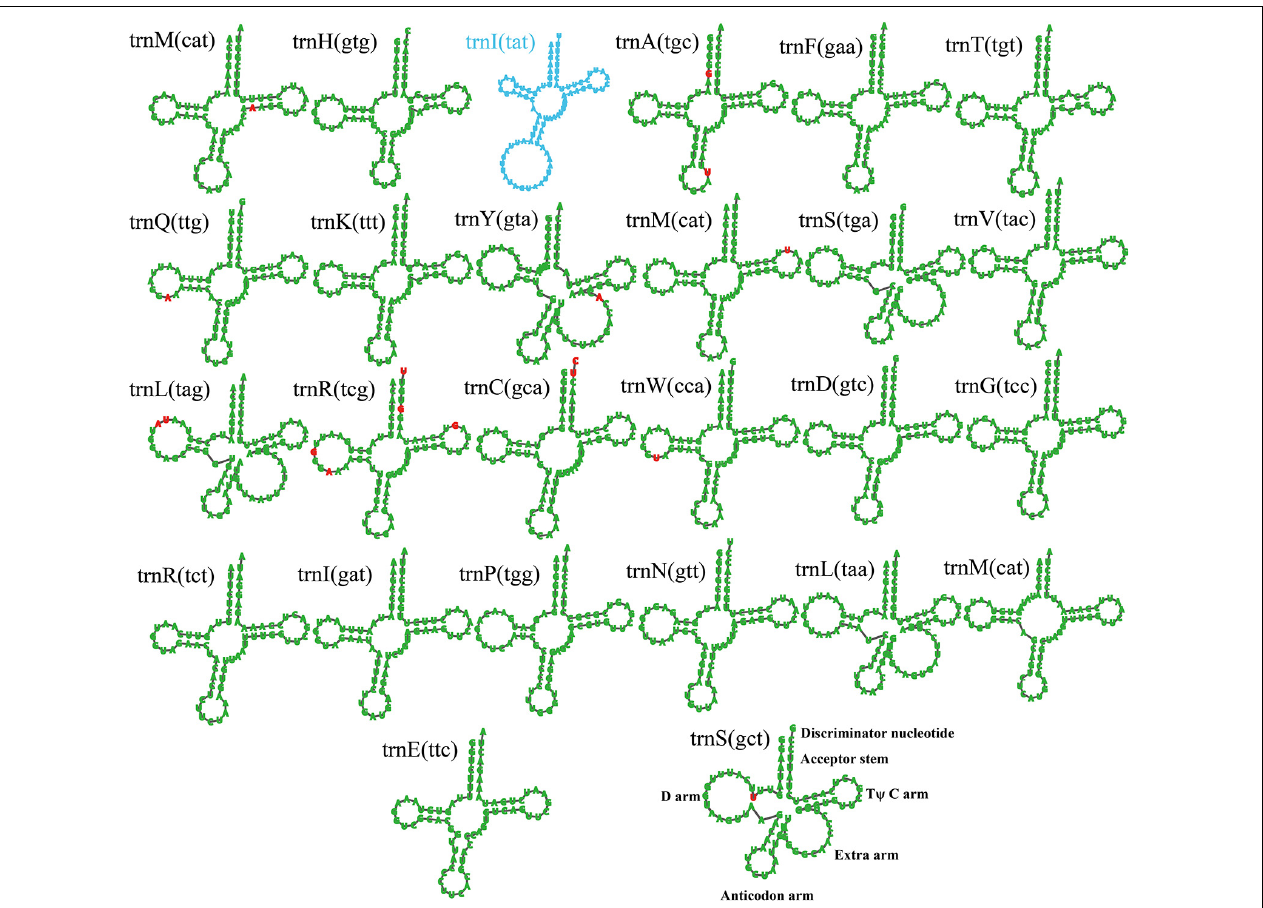
FIGURE 2 | Putative secondary structures of tRNA genes in the two Pisolithus mitogenomes. tRNA genes with green color represent tRNAs shared by the two Pisolithus species, while tRNA genes with blue color represent the unique tRNAs in Pisolithus microcarpus . Residues conserved across the two mitogenomes are shown in green, while variable sites are shown in red. All genes are shown in order of occurrence in the mitogenome of Pisolithus microcarpus , starting from trnM